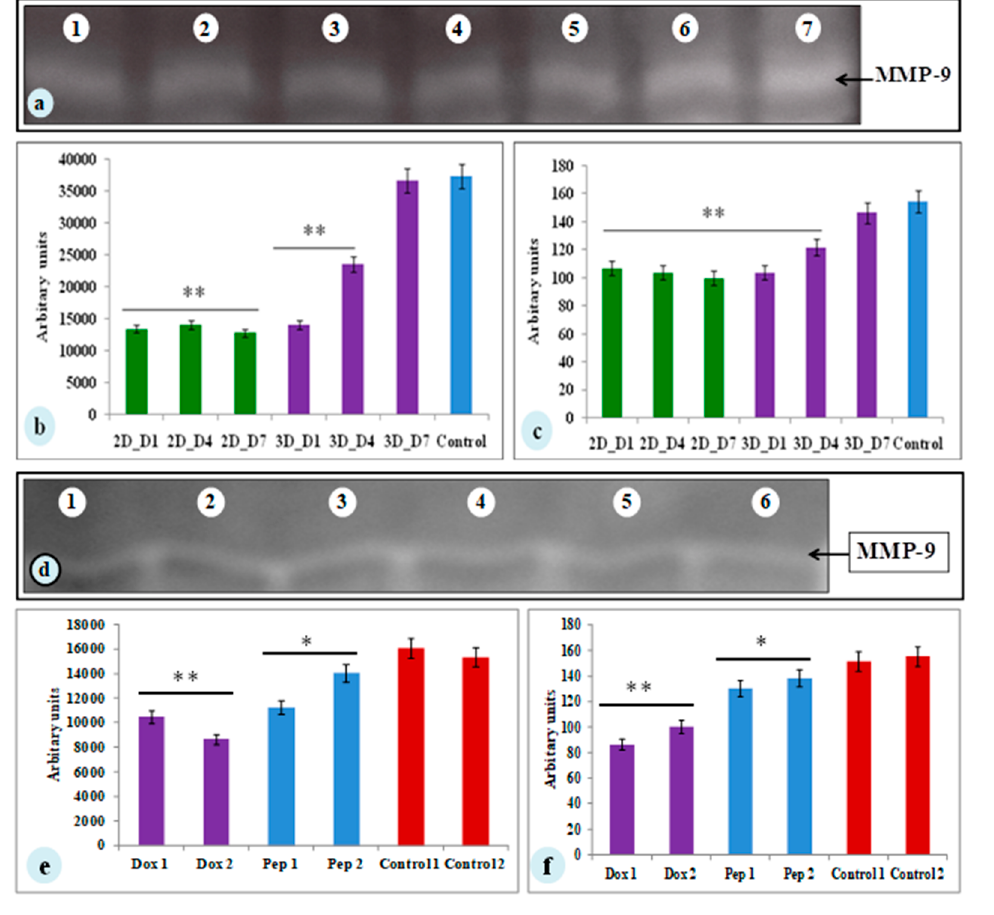
Figure 5. The zymograph of spent media from MDA-MB-231 cells cultured on constructs. ( a ) Lane 1– Lane 3: 2D A. mylitta coated silk constructs (Day 1, Day 4, Day 7), Lane 4–Lane 6: 3D A. mylitta silk fibroin sca ff olds, Lane 7: collagenase (positive control). Bands were analyzed using Image J –NIH software and represented as ( b ) mean area and ( c ) mean intensity (arbitrary units). Zymograph of drug treated spent media from MDA-MB-231 cells grown on 3D constructs. ( d ) Lane 1–Lane 2: doxorubicin treated (1 and 100 µ g / mL) A. mylitta silk fibroin constructs, Lane 3–Lane 4: cyclosaplin treated (1 and 100 µ g / mL) A. mylitta silk fibroin constructs, Lane 5: control, and Lane 6: collagenase (positive control). Bands were analyzed using Image J software and represented as ( e ) mean area and ( f ) mean intensity (arbitrary units). * P < 0.05; ** P < 0.01.; Dox—Doxorubicin; Pep—Peptide,